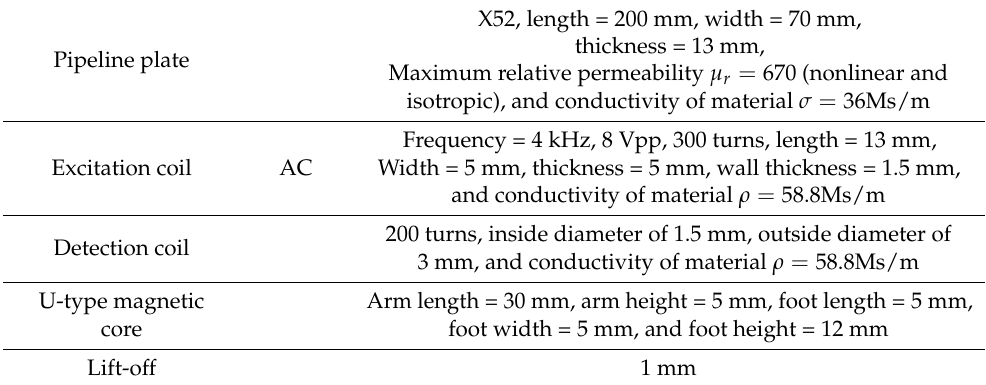
Table 1. Simulation calculation model parameters.